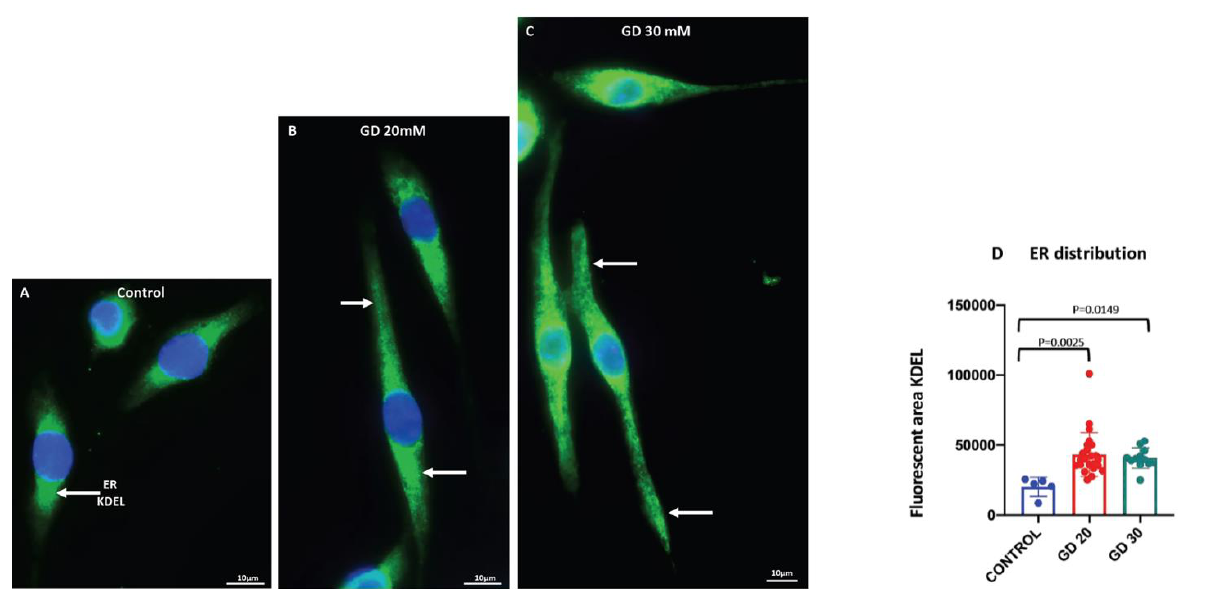
Figure 10. Dotarem caused a redistribution of the ER. ( A – C ) Images of RAW 264.7 macrophages untreated (control) and treated with 20 and 30 mM Dotarem (GD20, GD30) immunostained with the endoplasmic reticulum (ER) marker KDEL (green) antibody. Nuclei are stained blue with DAPI. All are merged images. ( A ) In the untreated control cells, the ER was located in the cell body in the vicinity of the nucleus (arrow). ( B , C ) In the Dotarem-treated cells, the ER was distributed within the larger area and in the extensions (arrows). ( D ) The graph shows that the differences (calculated from three experiments) in ER distribution between the control and the Dotarem (GD)-treated cells were statistically highly significant.